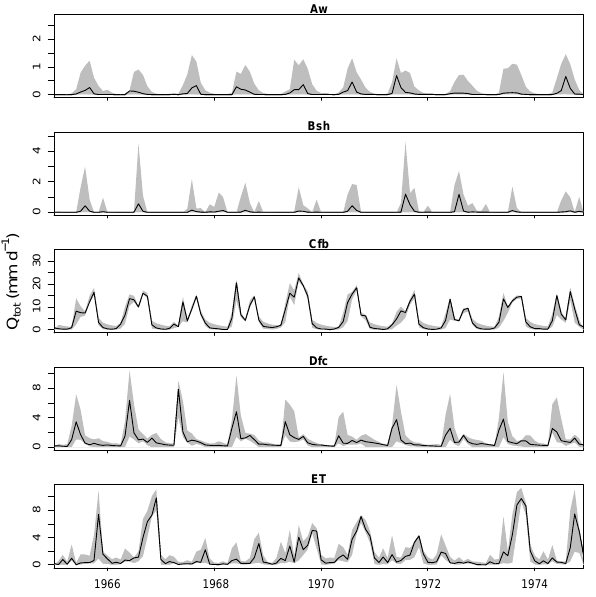
Fig. 3. Time series of total runoff. Ensemble median (black line) and the range of the models (gray zone) for several, randomly chosen, single grid cells in different climate regions.